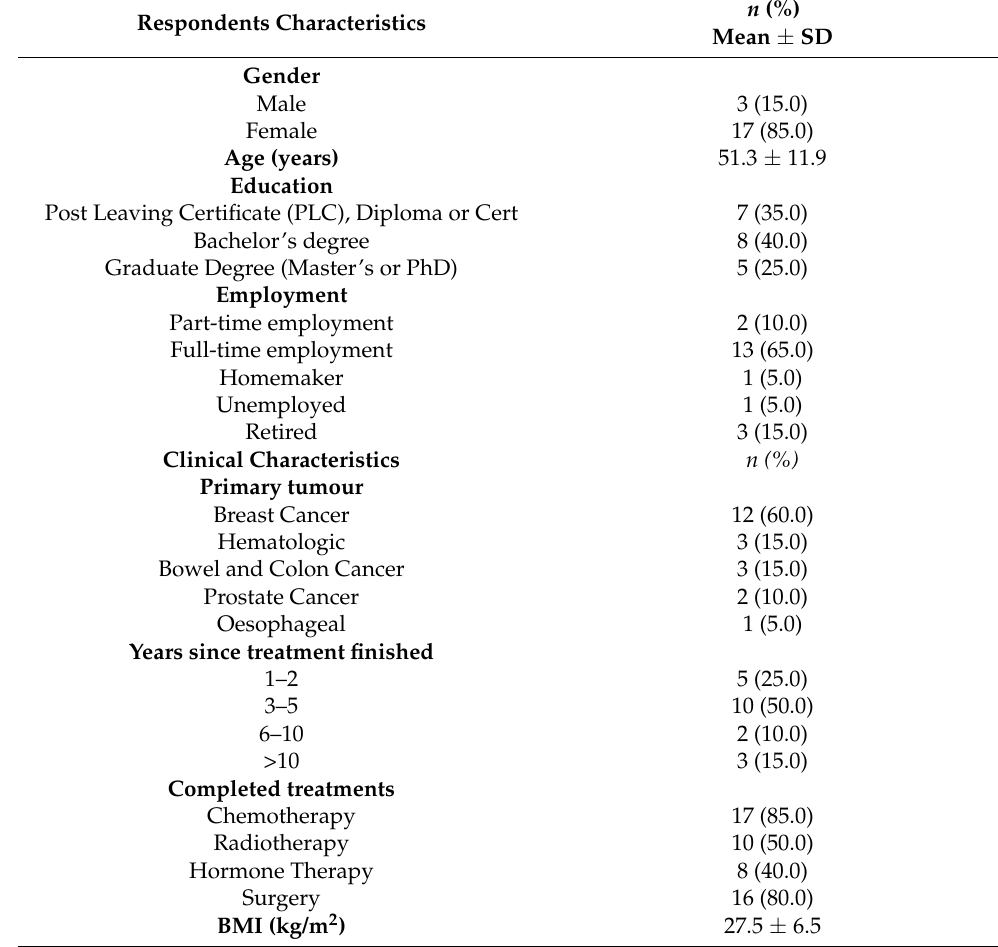
Table 2. Characteristics of the cancer survivors ( n = 20) who participated in the study.